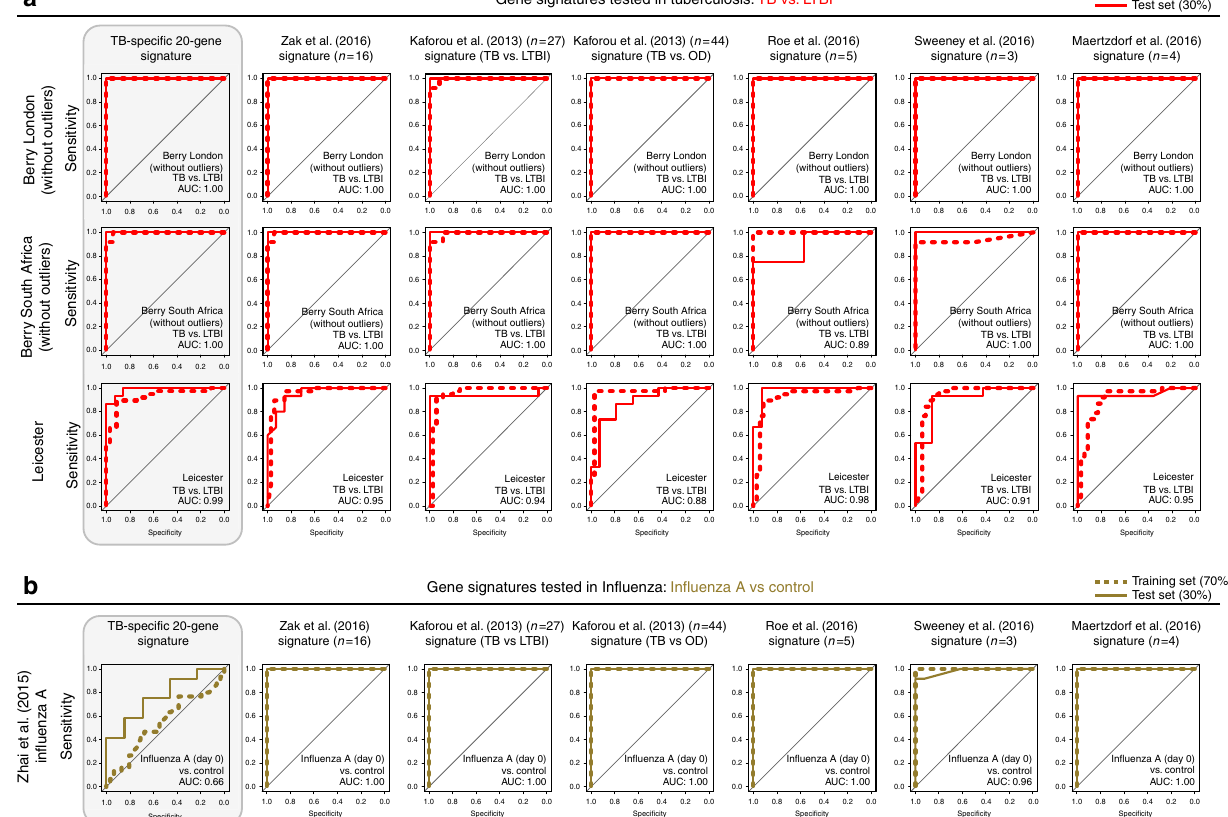
Fig. 8 Comparison of our TB-speci fi c 20-gene signature and others in distinguishing TB and in fl uenza. a Receiver operating characteristic curves (ROC) depicting the predictive potential of the TB-speci fi c 20-gene signature and the other published gene signatures in classifying a sample as TB or LTBI in the Berry London, Berry South Africa and Leicester cohorts, and b in classifying a sample as in fl uenza A or control in the Zhai et al. 36 dataset. Area under the curve (AUC) is shown for each ROC